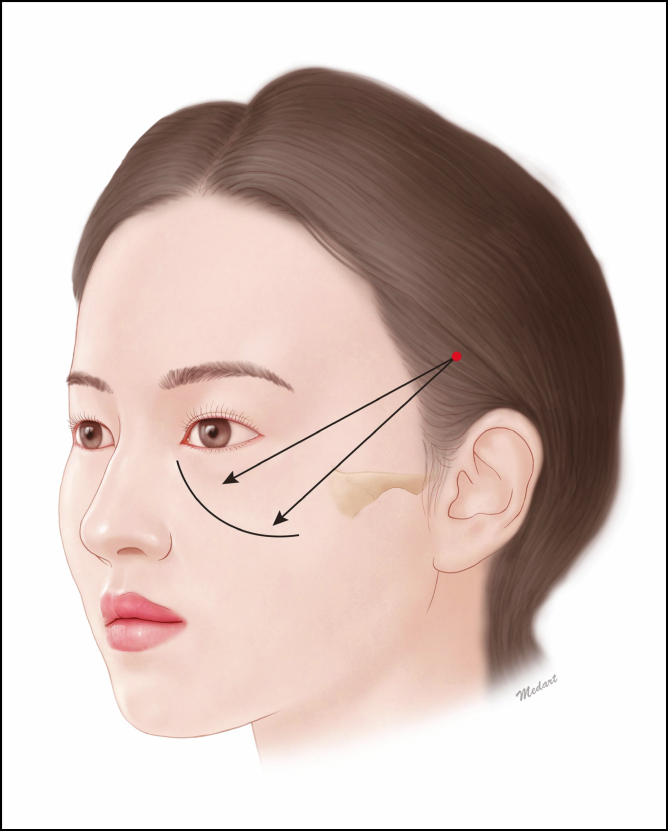
Design of midfacial lifting. The entry point is determined below the temple, and the exit one is located within the lateral canthus but not displaced to the zygomatic cutaneous ligament.